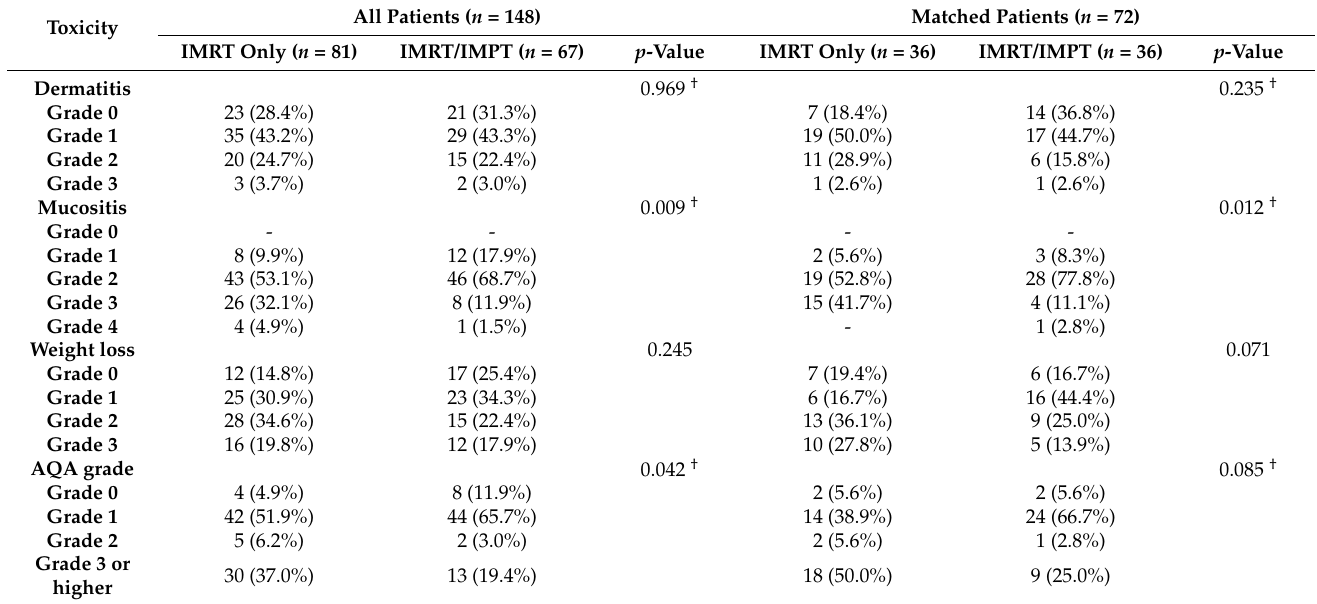
Table 2. Acute toxicity profiles.